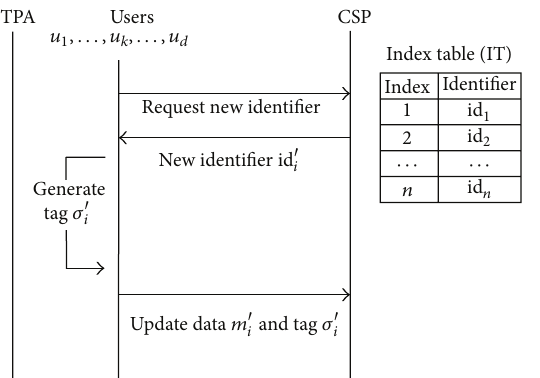
Figure 1: Data update flows when the only CSP manages an index